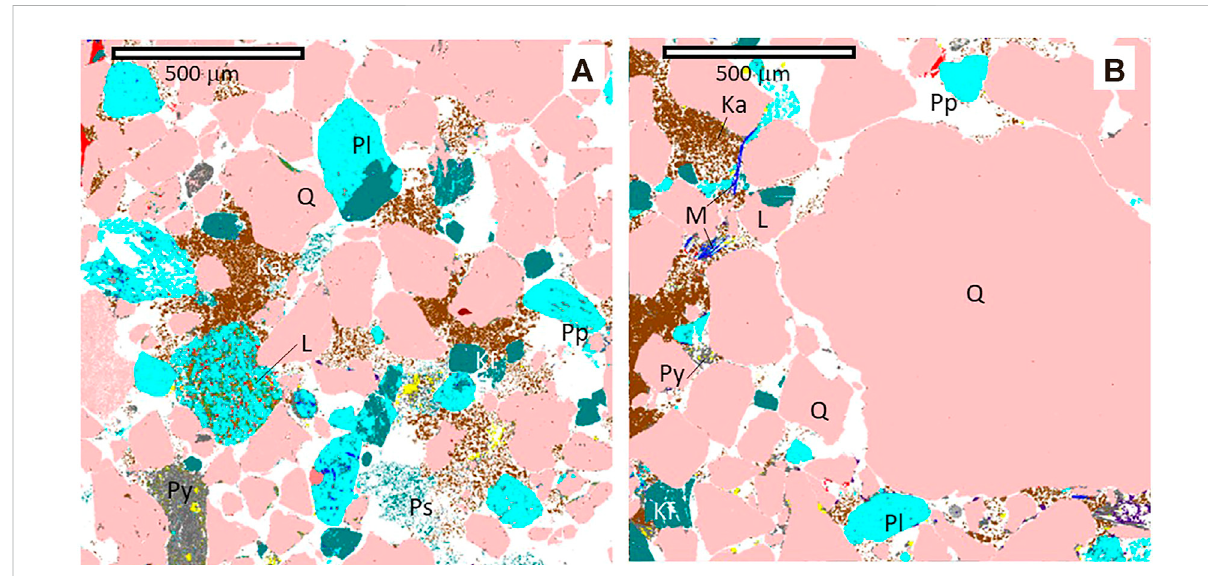
FIGURE 9 Palaeocene marine fan sandstones from the Outer Moray Firth Basin, Central North Sea, United Kingdom (mineral colour index in Figure 3). (A) Moderately-sorted, medium porosity, quartz (Q)-rich sand containing K-feldspar (Kf), plagioclase (Pl), lithic (L) grains and pyritised (Py) grains. There arelargepatches ofkaolinite(Ka)thatareapproximatelygrain-sizedsuggesting that kaolinitehasreplaced apre-existinggrain(probablyK-feldspar). Kaolinite growth seems to be the only signi fi cant diagenetic phase despite the sandstones being buried to about 2,000 m (72 ° C). (B) Very poorly-sorted, low-to medium-porosity, quartz-, plagioclase and K-feldspar- and muscovite (M-bearing sand containing grains with a wide variety of grain sizes. There are large patches of kaolinite that are grain-sized, as in Figure 9A, suggesting that kaolinite has replaced a pre-existing grain (probably K-feldspar). The lower porosity in image 9B compared to 9A is due to the poorer sorting in